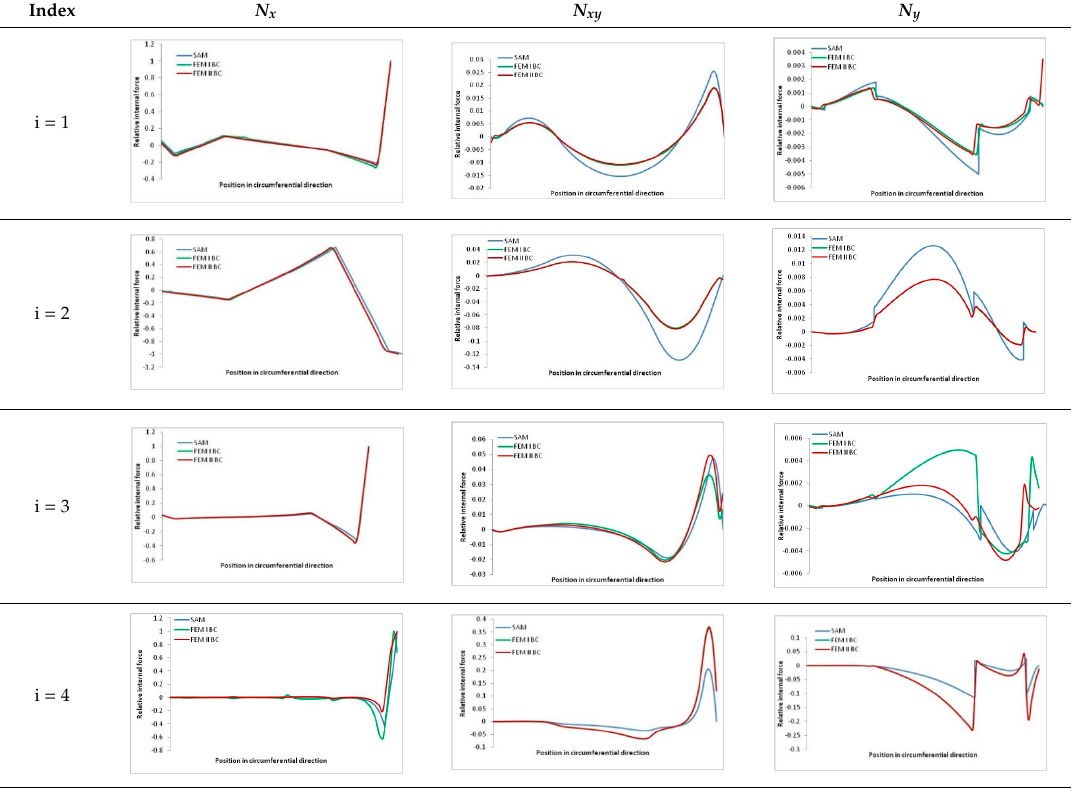
Table 9. The distribution of internal forces N x , N y and N xy for the LC–3 beam.